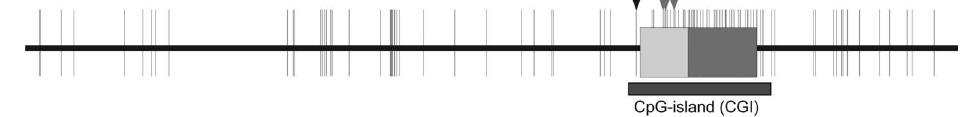
Figure 2 Schematic representation of the Tnfsf11 gene starting at -2000 to q 1000 bp estimated from the transcription start site (TSS). Analyzing the methylation status around the TSS (TATA-box) revealed that methylation of only one CpG (black triangle) abrogates the expression of Tnfs11 in osteoblasts. This CpG was never methylated in the osteoblasts of BALB/c mice, but is methylated in other tissues that do not express Tnfs11 . The methylation status of CpG indicated by the gray triangle did not influence the expression of this gene in osteoblasts and was found to be methylated in all tissues investigated (168). The results indicate that methylation of individual nucleotides in CpG-rich regions at the TSS is critical for regulation of gene expression. The black line indicates the 5 9 non-coding region. The 5 9 untranslated region is indicated by the light gray box and the translated region of the first exon is indicated by the dark gray box. The start of the light gray box is the TSS. The black line after the first exon indicates a part of the first intron. The CGI was calculated using the MethPrimer software (172). The applied settings define a CGI when a DNA stretch of 200 bp (window size) has a GC-content ) 50% and the observed-to-expected ratio of C/G ) 0.6